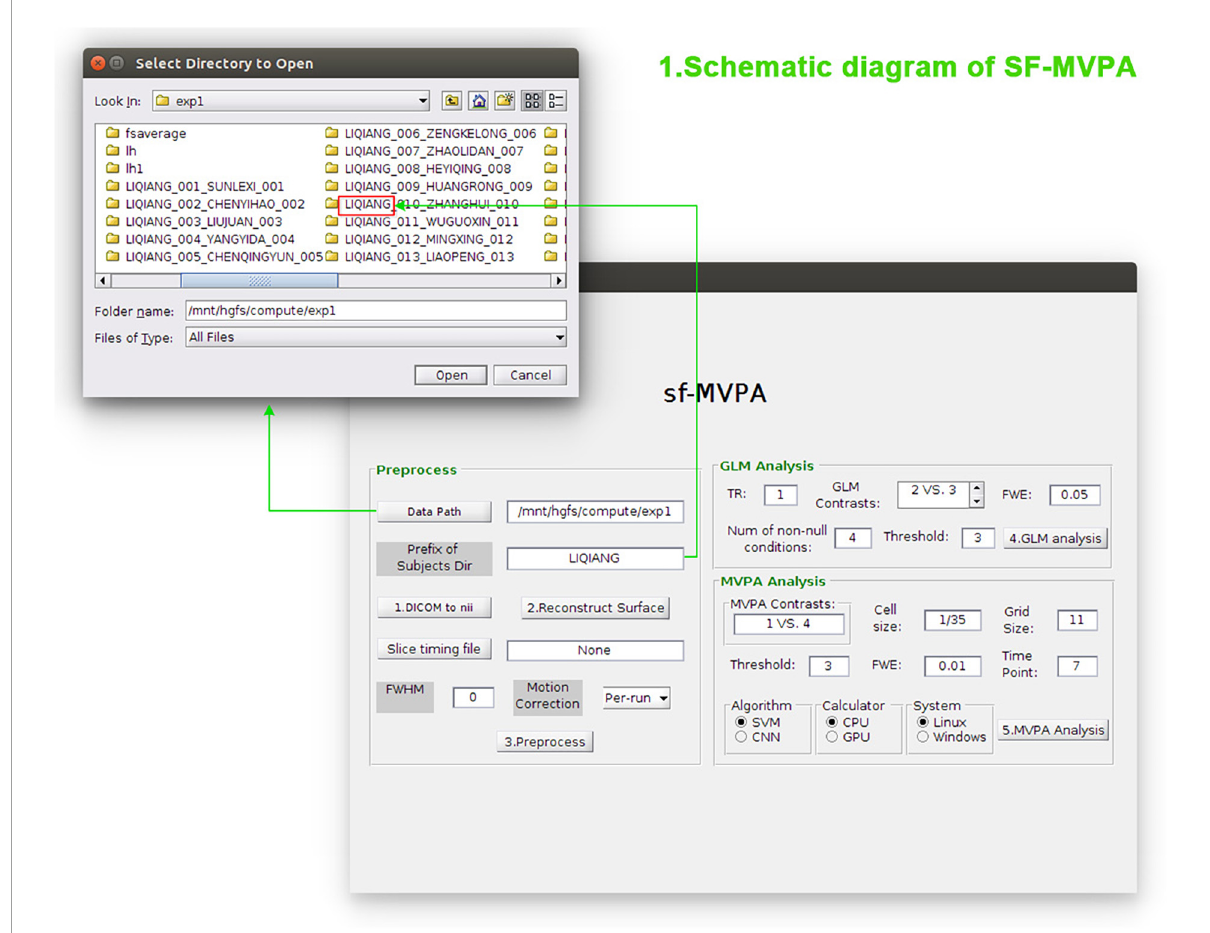
FIGURE1 Schematic diagram of SF-MVPA. In the Preprocess module, the user needs to enter parameters such as the data path, prefix of subject folders, slice timing file, full width at half maxima (FWHM), and motion correction. After that, the user can click the buttons “1.DICOM to nii,” “2.Reconstruct Surface,” and “Preprocess” in sequence to convert the raw data format, reconstruct the surface, and preprocess the data. In the general linear model (GLM) analysis module, parameters such as TR, GLM contrasts, FWE threshold, number of non-null conditions, and vertex-wise threshold (Threshold) need to be entered before performing GLM analysis. In the multivariate pattern analysis (MVPA) module, parameters such as MVPA contrasts, cell size, grid size, vertex-wise threshold (Threshold), FWE threshold, time point (the time after stimulus onset), algorithm, and calculator need to be entered before performing surface space-based